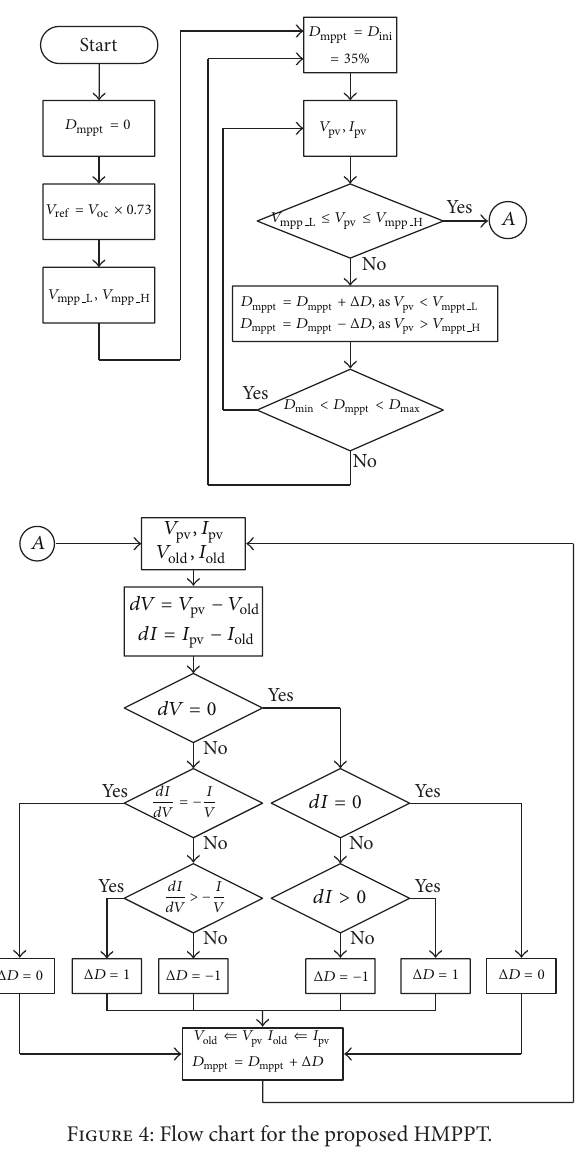
Figure 4: Flow chart for the proposed HMPPT.